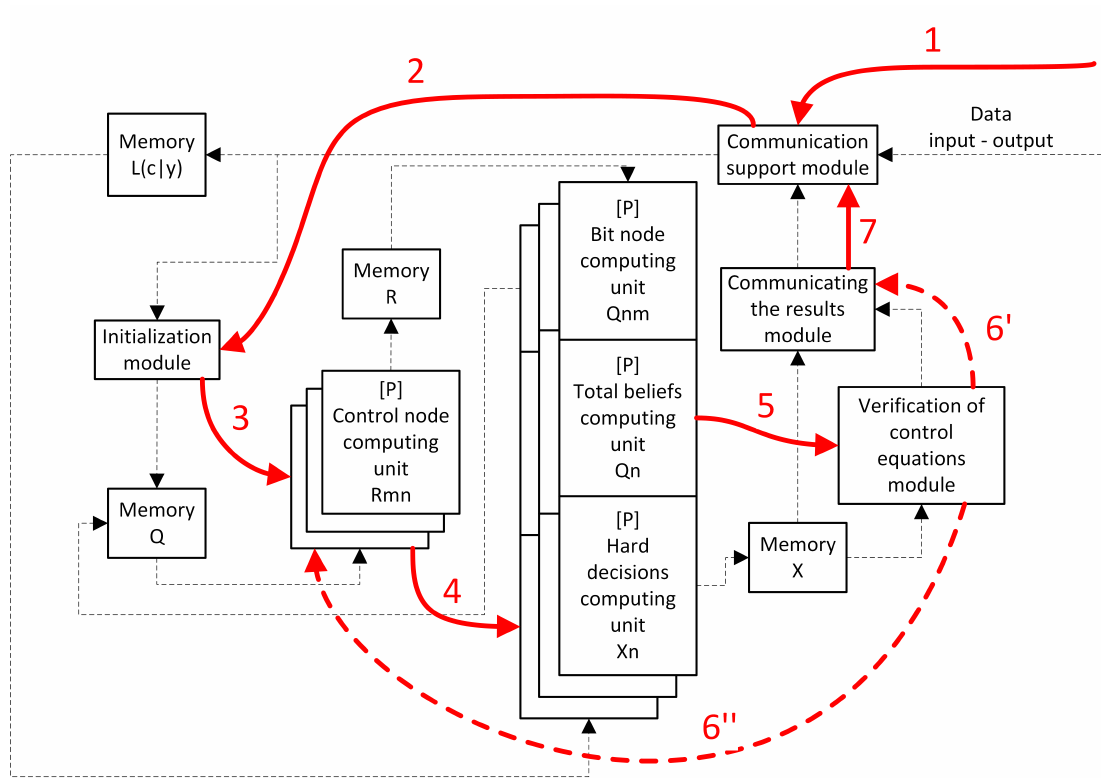
Figure 4. The block diagram of the designed QC-LDPC decoder and the idea of transferring the Token (with the order marked) between the elements of the